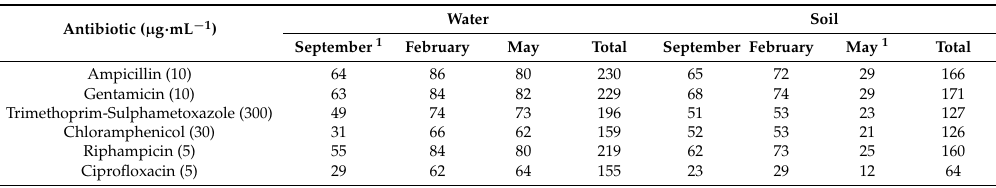
Table 1. Number of bacterial isolates resistant to each antibiotic from samples of water and soil taken at recreational parks during three seasons.